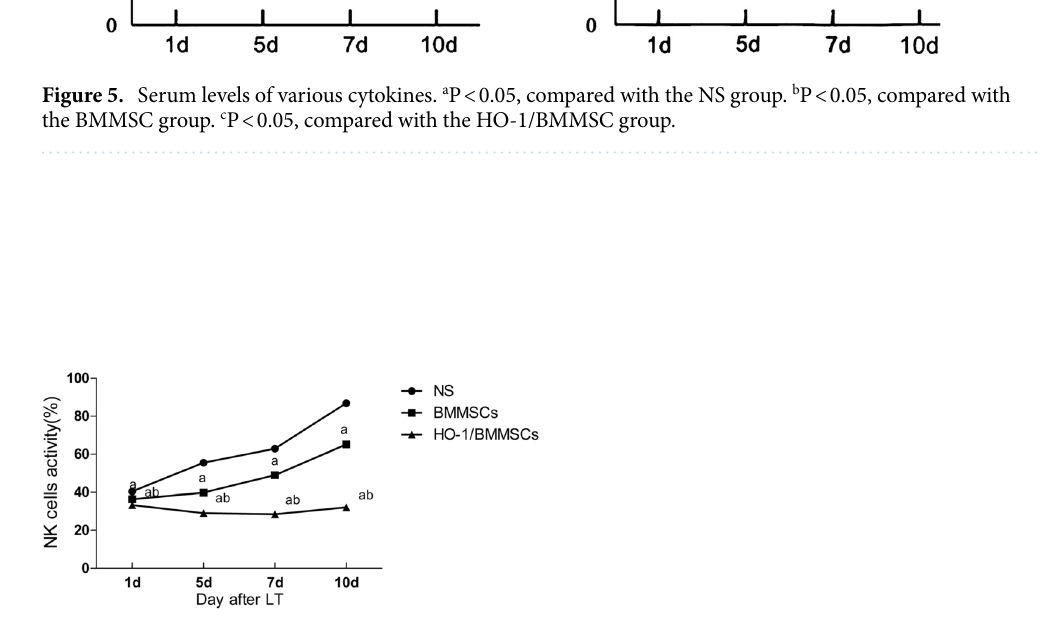
Figure 6. NK cells activity. a P < 0.05, compared with the NS group. b P < 0.05, compared with the BMMSC